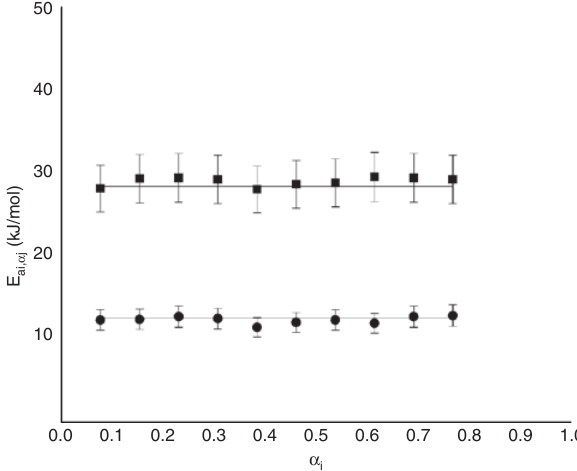
Table 5: The calculated values of ∗